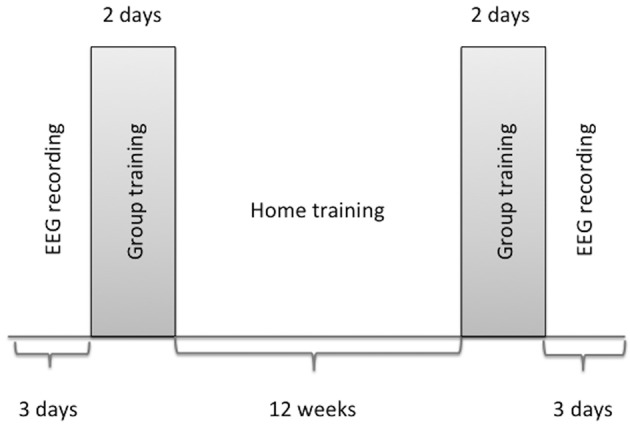
Design of the study.